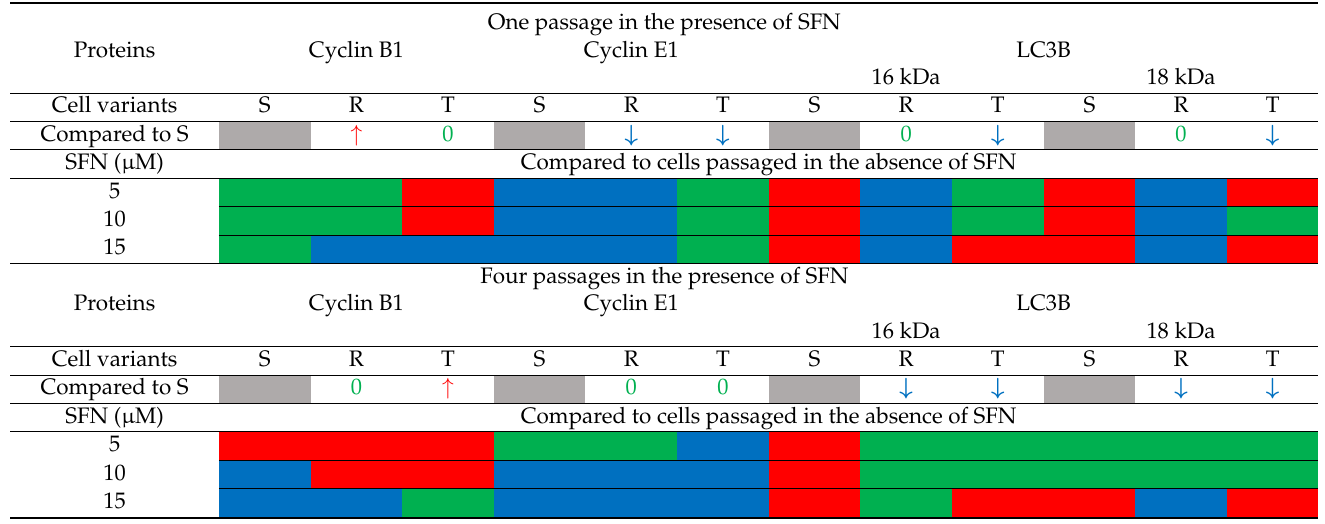
Table 2. Summary of changes in the cell content of the indicated protein after different passage procedures of S, R and T cells in the presence of